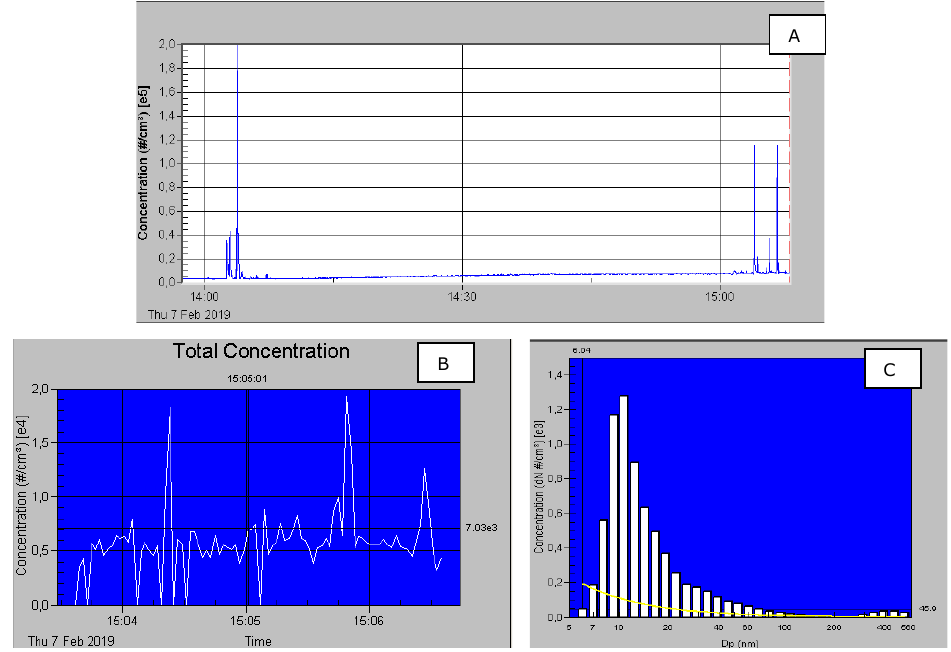
Figure 3 . Nanoparticles during ABS printing. A (CPC concentration), B (EEPS concentration), C (EEPS size distribution) On the 20 th of February, during printing PLA filament, an average concentration of 3.780 particles/cm 3 was observed, Figure 4A and Figure 4B. The concentration remained steady during printing. Typical submicron particle size distributions are shown in Figure 4C. Most of the particles emitted during printing were less than 200 nanometers with a number peak around 80 nm.